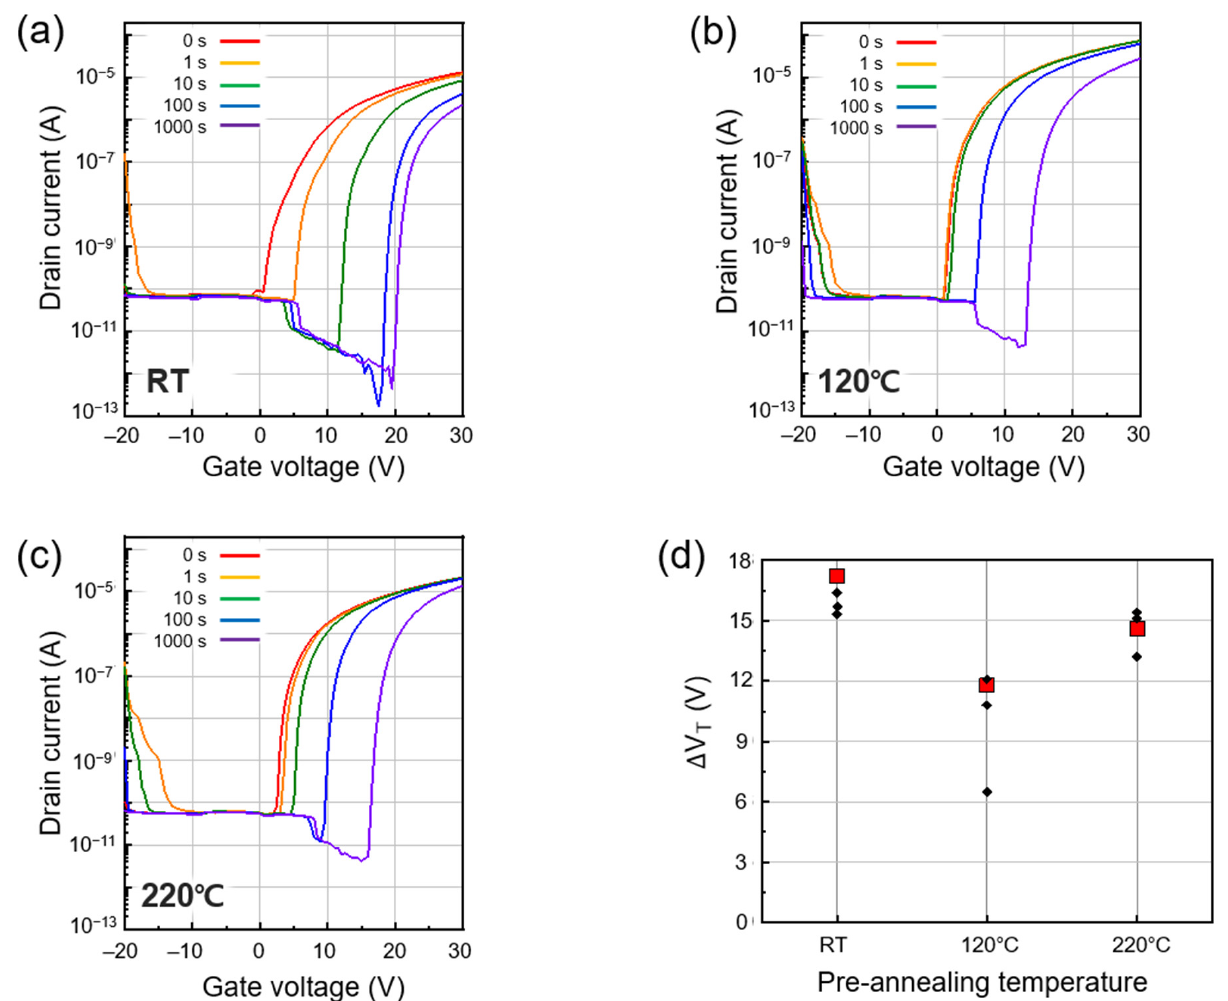
Figure 5. Transfer curves of the ZTO TFTs pre-annealed at ( a ) RT, ( b ) 120 °C, ( c ) and 220 °C for different durations of the PBS test. ( d ) Threshold voltage shift ( Δ V T ) after 1000 s of the PBS test of the ZTO TFTs pre-annealed at different temperatures. The red squares are the Δ V T values extracted from Figure 5a–c, and the black diamonds are the Δ V T values extracted from the PBS test results of the same method not presented here.